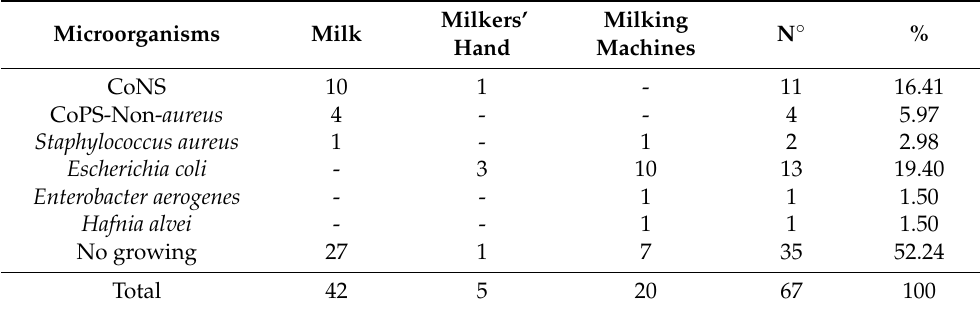
Table 3. Frequency of microorganisms isolated from milk samples, hand swabs from milkers and milking machines, in the municipality of Juranda, northwestern Paran á State, Brazil, May–June 2022. Milkers’ Microorganisms Milk Hand